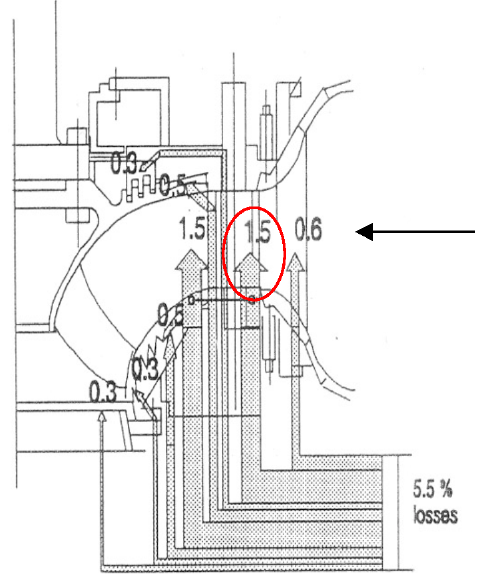
Figure 3. Losses in Francis turbine.